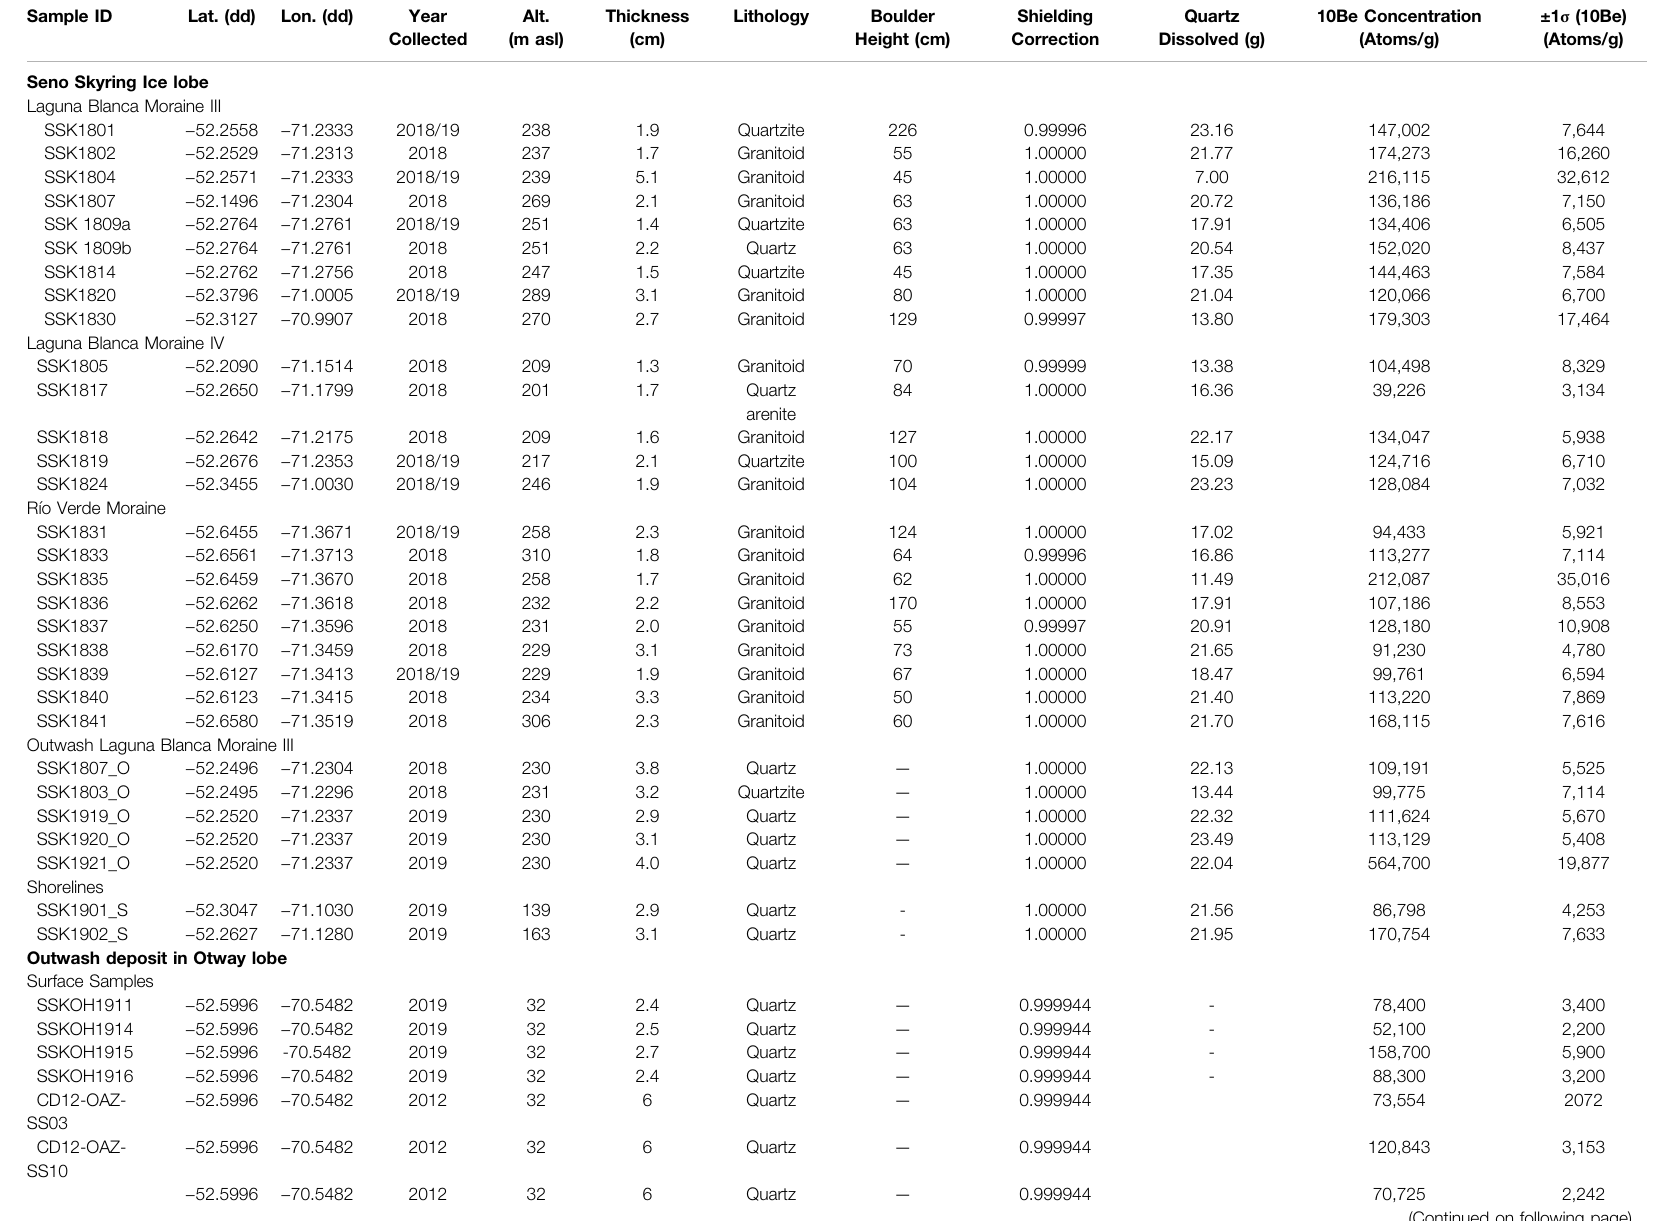
TABLE 1 | Sample details and 10 Be concentrations from Skyring ice lobe and the outwash deposit located in Otway basin, associated with the southeastern Laguna Blanca spillway. The samples are grouped by